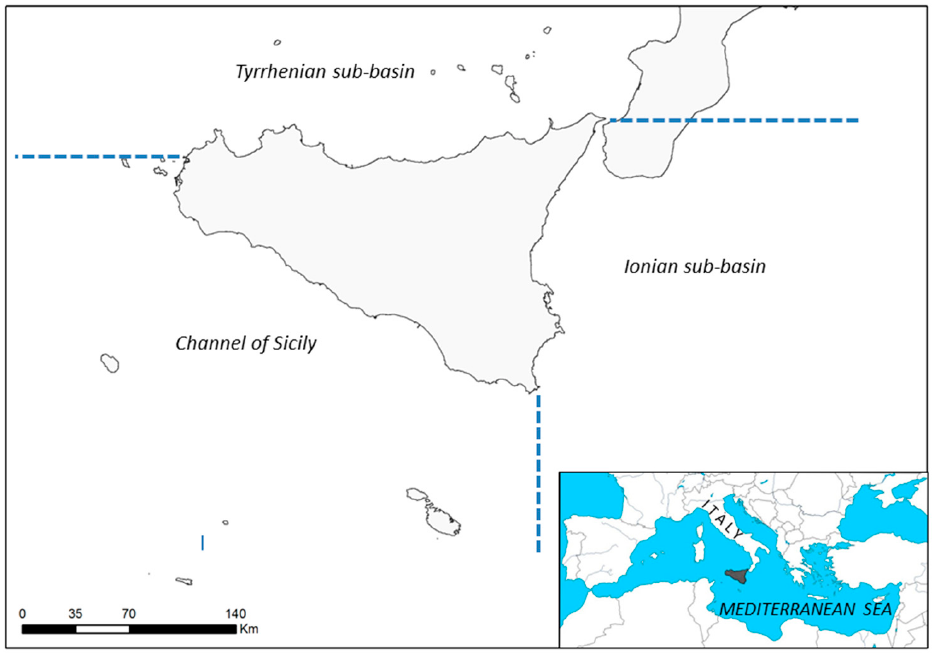
Figure 1. Map showing the partitioning of the Sicilian coast for the assessment of cetacean strandings: the Tyrrhenian sub-basin (northern Sicilian coast), the Ionian sub-basin (eastern Sicilian coast), and the Channel of Sicily (southern Sicilian coast). The insert indicates the position of Sicily Island in the Mediterranean